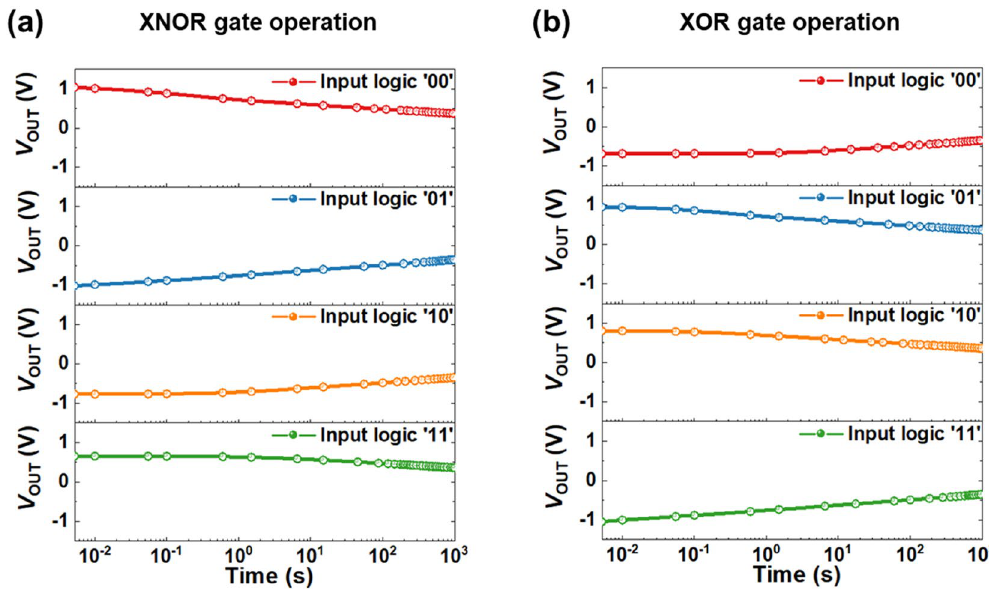
Figure 5. Logic retention characteristics of ULIM cell. V OUT versus time during the hold operation for ( a ) XNOR and ( b ) XOR logic gate